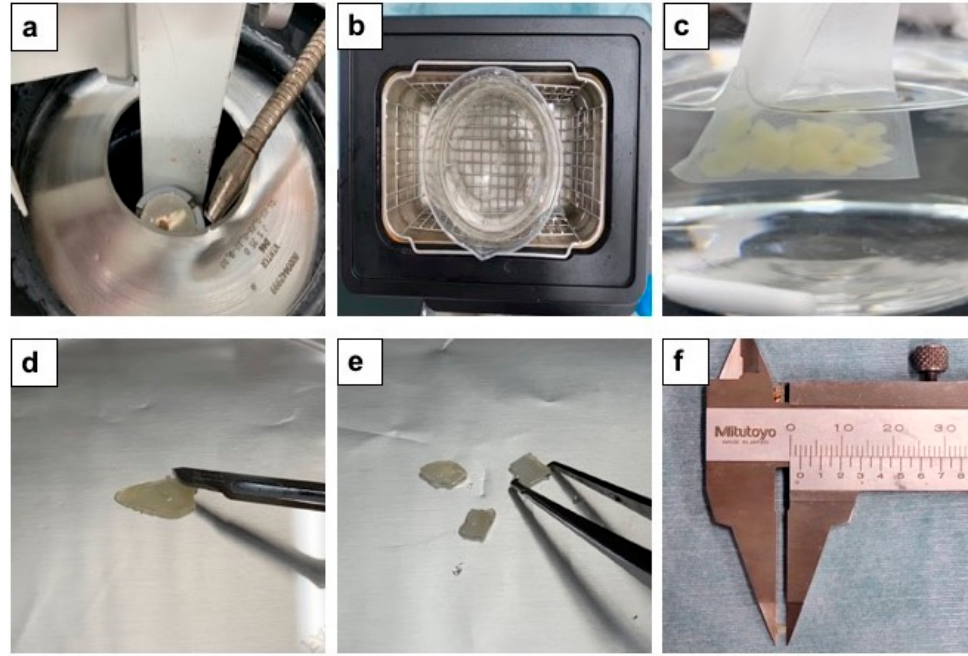
Figure 1. Preparation of human dentin blocks. ( a ) Dentin ‐ root portion was sliced into several disks (1.0 mm in thickness) by using electrically rotating cutting machine (Leica SP1600 Germany), ( b ) Ultrasonic demineralization in 2% HNO 3 liquid (1.0 L) for 30 min, ( c ) Ultrasonic washing in D.W. (1.0 L) for 30 min, ( d – f ) Demineralized dentin disks were cut into blocks (2 × 2 × 1 mm 3 ).